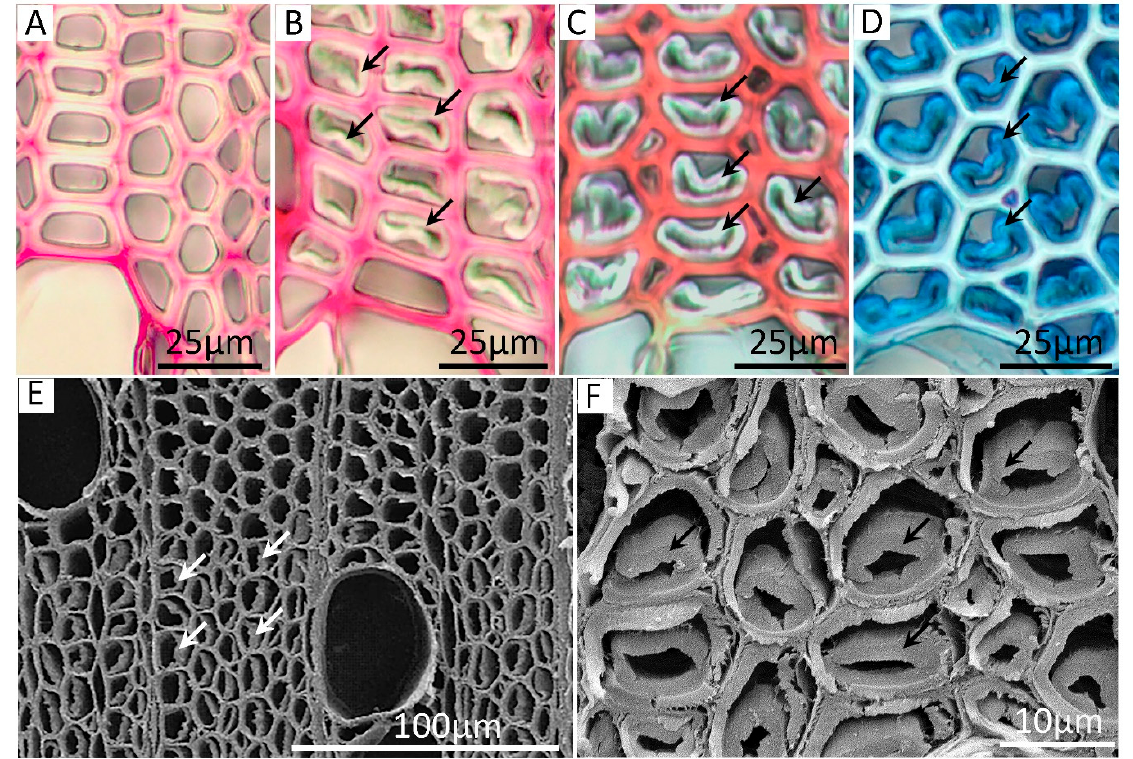
Figure 4. Light microscopy and scanning electron microscopy (SEM) images of typical transverse sections from the S. viminalis clones with normal mature and tension wood fibers with a gelatinous layer (arrows); ( A , B ) normal and tension wood fibers stain pink/red with the Wiesner reaction with vessel cell walls and middle lamellae. There is a weak reaction with the fiber secondary cell walls, and the G-layer is negative (arrows); ( C ) Mäule reaction with strong orange staining of fiber secondary cell walls and negative reaction with the G-layer; ( D ) G-fibers after staining with astra blue with detached G-layers; ( E , F ) SEM images showing thickness of typical G-layers in early- and latewood fibers from the clones. Note, in ( E ), the upper part of the image shows earlywood fibers without G-layers and the lower part with G-layers.